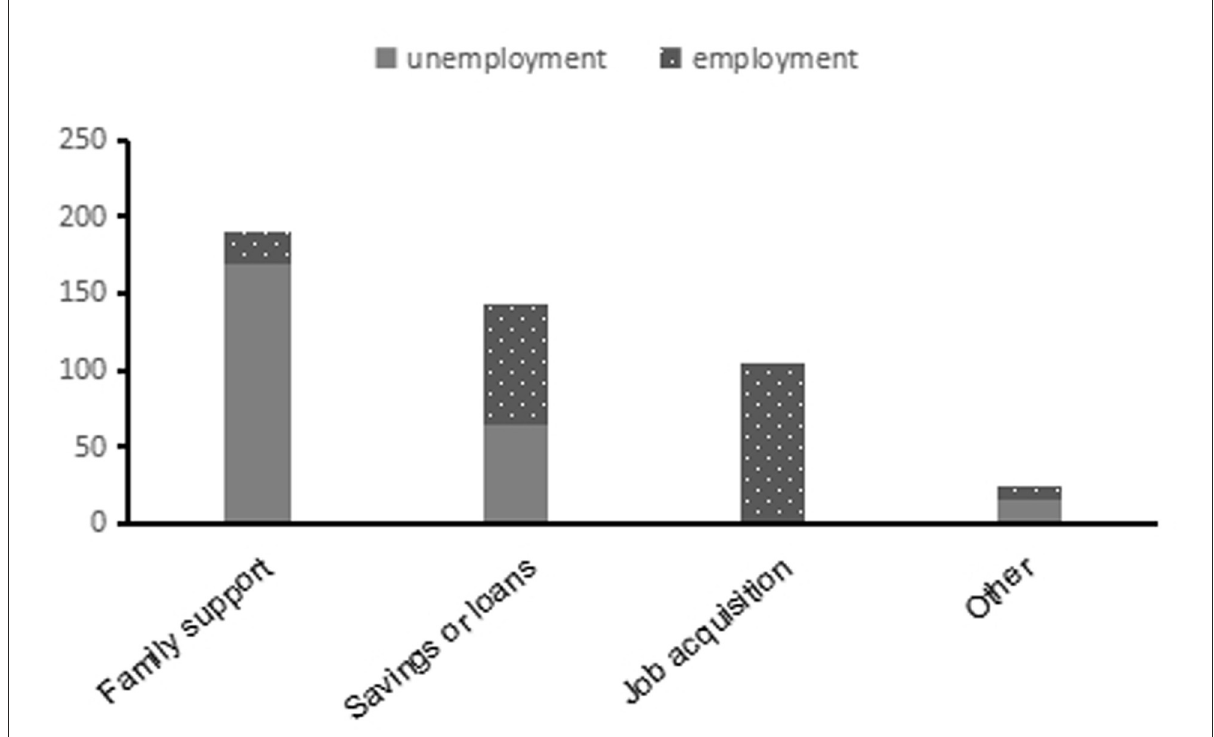
FIGURE2 Source of income. More than one source could apply to one